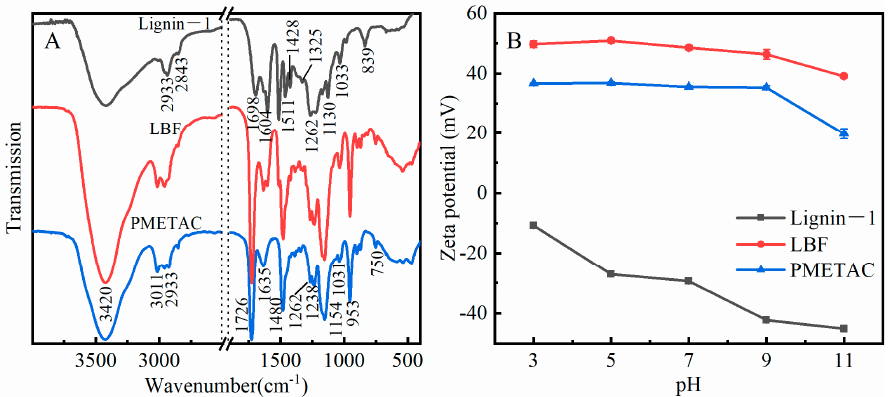
Figure 3. ( A ) FTIR spectra of Lignin-1, PMETAC and LBF, ( B ) zeta potential of Lignin-1, PMETAC and LBF as function of the